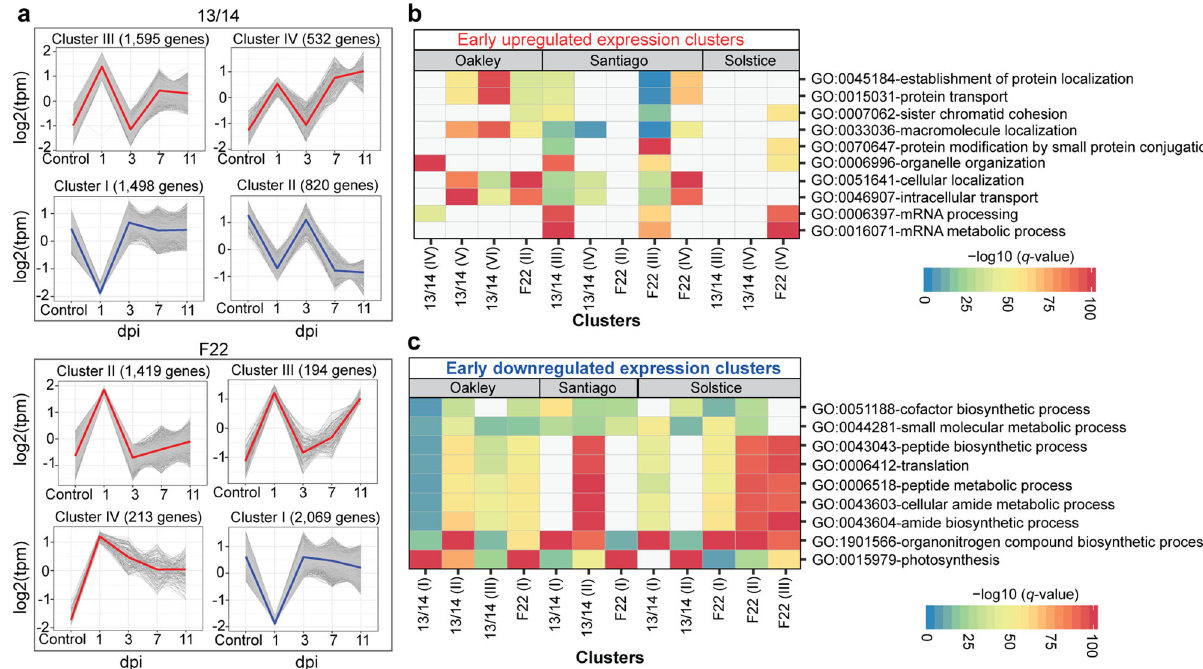
Fig. 3 Co-expression clusters for the wheat genes upregulated or downregulated early during Pst infection. a Example of co-expression clusters classi fi ed as containing ‘ early upregulated ’ (red) or ‘ early downregulated ’ (blue) genes following infection of Santiago with Pst isolates 13/14 and F22. Co- expression clusters were generated using the 8627 Pst 13/14-speci fi c DEGs. The coloured line represents the average normalised expression of all genes in a given co-expression cluster. b , c GO terms for functionally enriched biological processes across the co-expression clusters from 8627 Pst 13/14-speci fi c DEGs, assessed for each Pst – variety pair, and classi fi ed as ‘ early upregulated ’ ( b ) or ‘ early downregulated ’ ( c ) genes. Signi fi cant – Log( q -value) values are represented using a 0 – 100 scale and GO terms with – Log( q -value) > 5 are shown.